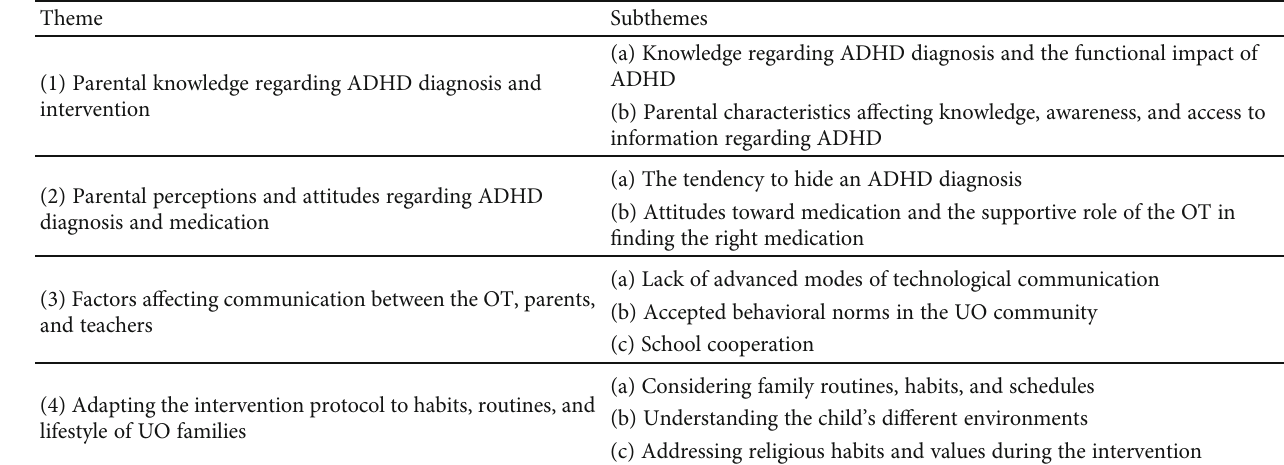
Table 2: Themes and subthemes of qualitative